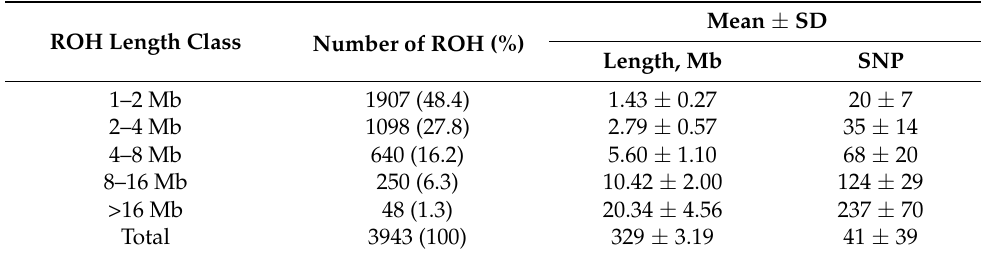
Table 2. Number, mean length, and number of single-nucleotide polymorphisms (SNP) of runs of homozygosity in different length